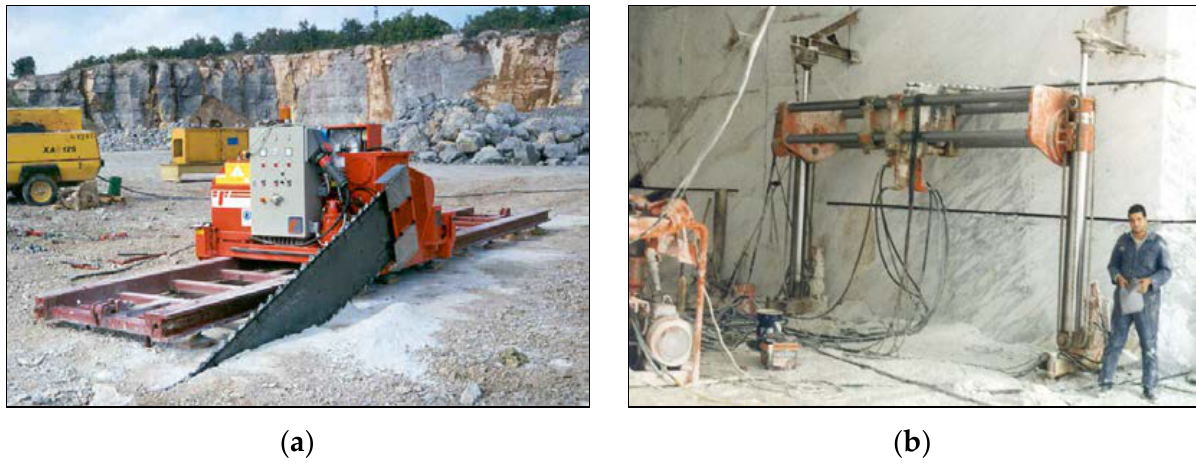
Figure 7. ( a ) A chain cutter operating on a bench to perform a vertical cut; ( b ) the version commonly adopted for underground use: the versatility of this machine allows the creation of additional free surfaces in bottom-blinded openings of “weak” stone quarries, for which it is very frequently adopted.